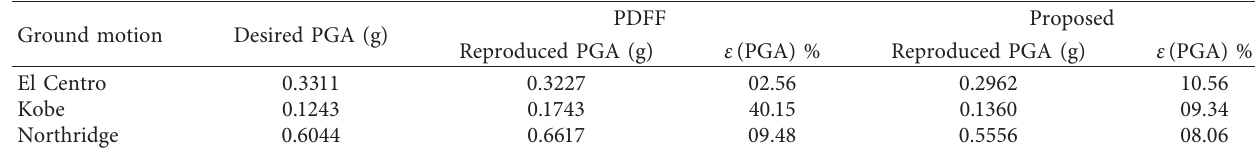
Table 7: Error in PGA reproduction for different earthquake records (unloaded table). Ground